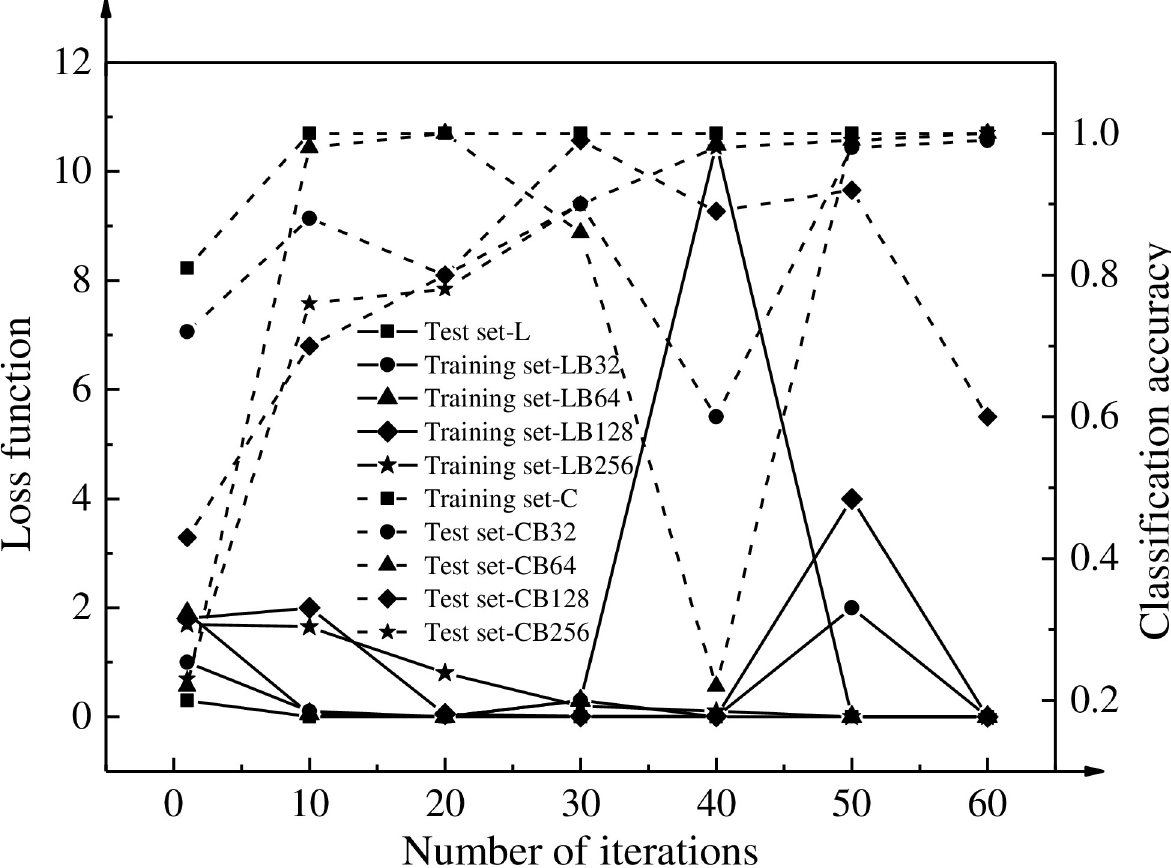
Fig 9. Changes in classification accuracy and loss function when the convolution kernel size is 3 � 1 (in the figure, L represents the loss function, C represents the classification accuracy, and B represents the batch size).